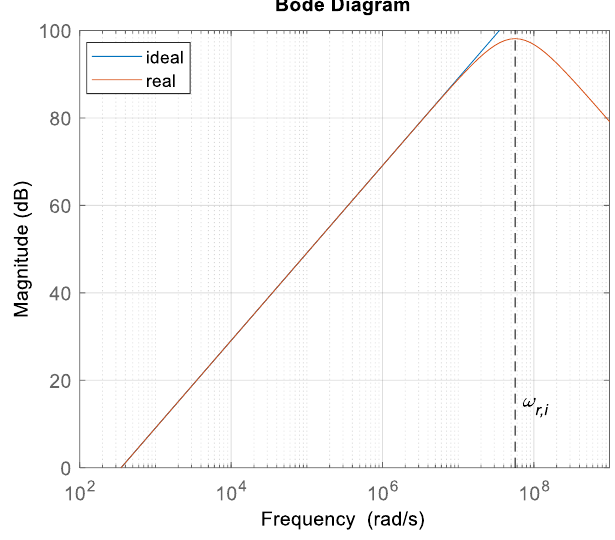
Figure 17. Bode plot of the search coil transfer function.